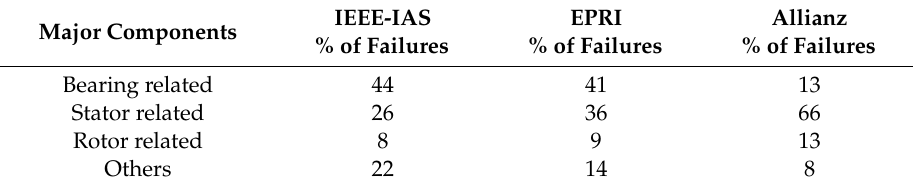
Table 1. Percentage of failure by component in induction